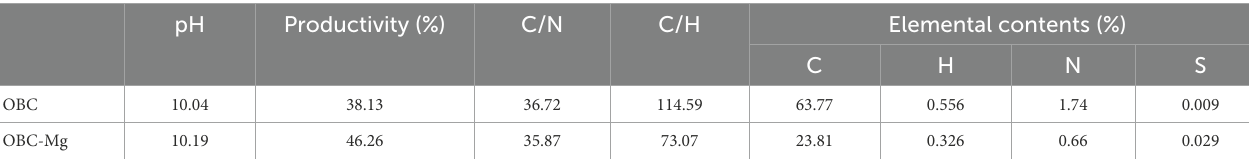
TABLE 2 Basic properties and elemental contents of two